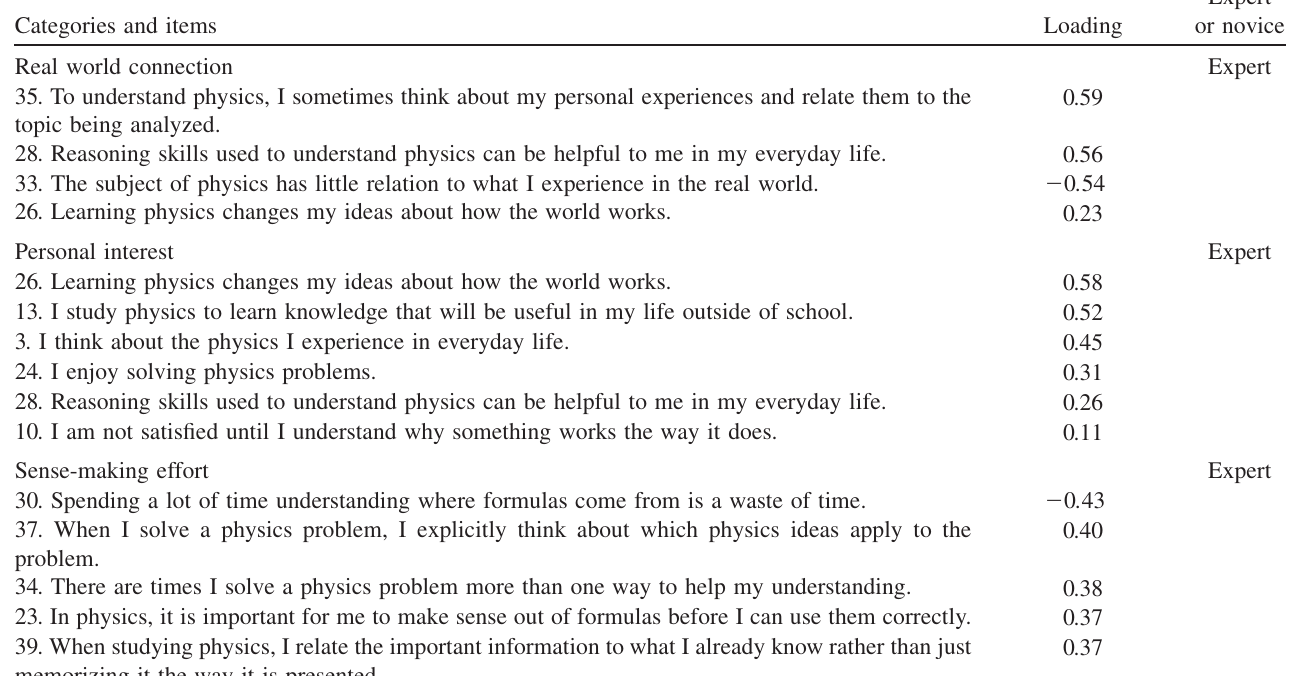
TABLE III. Contributions (loadings) of beliefs items selected from the CLASS survey [32] to corresponding base models. Expert or novice indicates whether the base model represents expert or novicelike beliefs and correlates with lab score in Fig. 1. Categories and items Loading